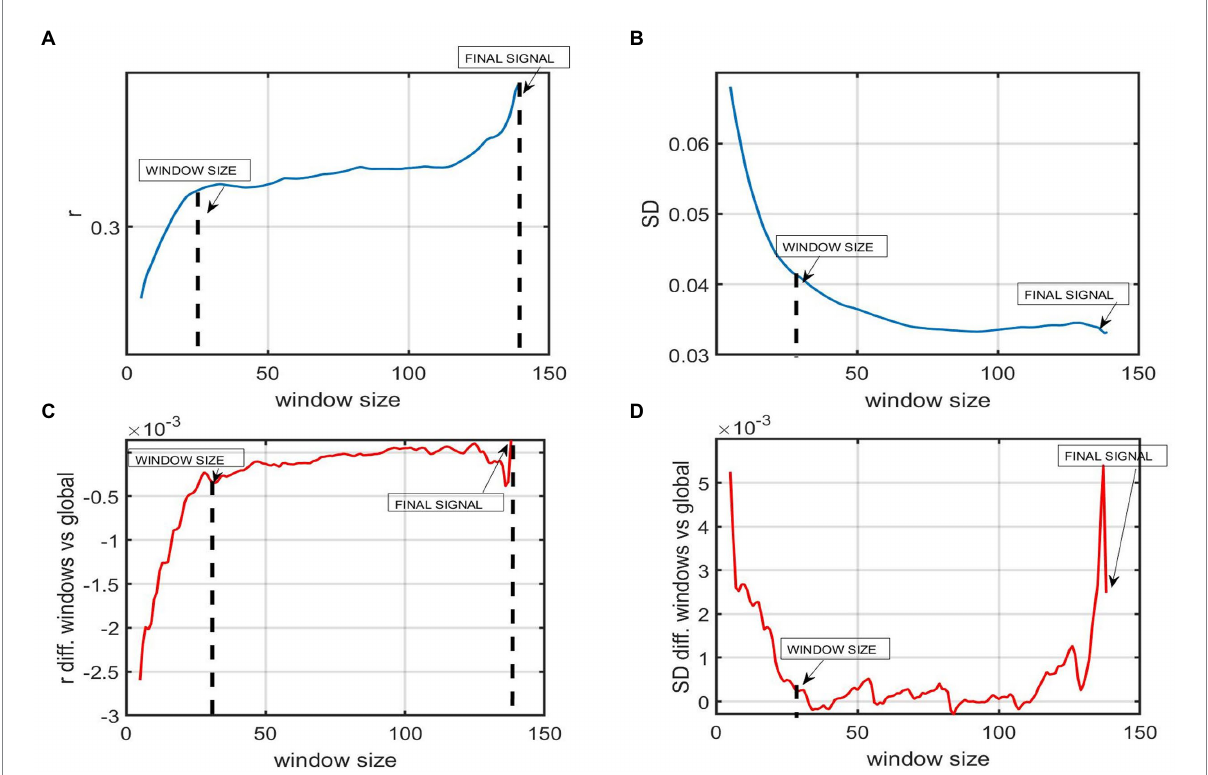
FIGURE 2 The figure represents the window size analysis before conducting the sliding window correlation analysis. (A) Global FC as a function of window size. The Y -axis represents the mean FC or correlation of all the ROI to ROI correlations windows of a participant with AD. The X -axis shows 140 time points of the whole time series. Each time point represents 3 s (TR = 3 s). The mean correlation varies as a function of window size. Shorter windows present a lower mean correlation while windows from 30 or above present a higher correlation. (B) The Y -axis represents the mean standard deviation (SD) of the SD of all the ROI to ROI correlations across windows of a participant with AD. The X -axis shows that this mean SD varies as a function of window size. Shorter windows present a higher variability while windows of 30 time points or above present a lower SD. (C) The plot shows the difference between the mean correlation of all ROI to ROIs using a certain window size and the global static (D) The difference in the variability among windows using window sizes higher than 30 fluctuates around 0, meaning that results in SWA are almost the same, no matter the window length